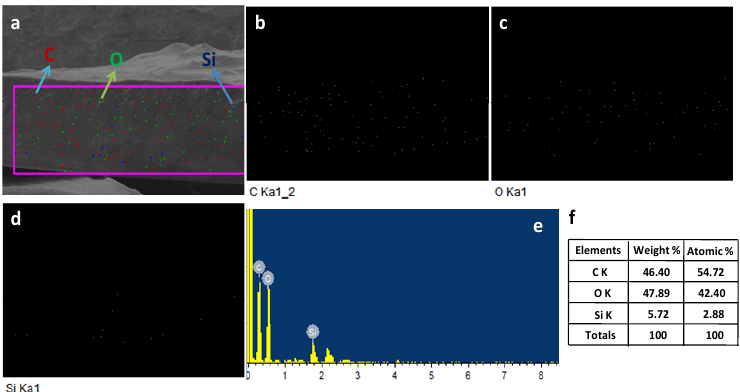
Figure 1. ( a ) Cross ‐ sectional image of a QPVA/5%FS nanocomposite membrane and the scanning area for EDX mapping; ( b ) EDX mapping of carbon; ( c ) EDX mapping of oxygen; ( d ) EDX mapping of silica; ( e ) EDX graph of QPVA/5%FS; ( f ) Percentage of elements present in QPVA/5%FS nanocomposite membranes.